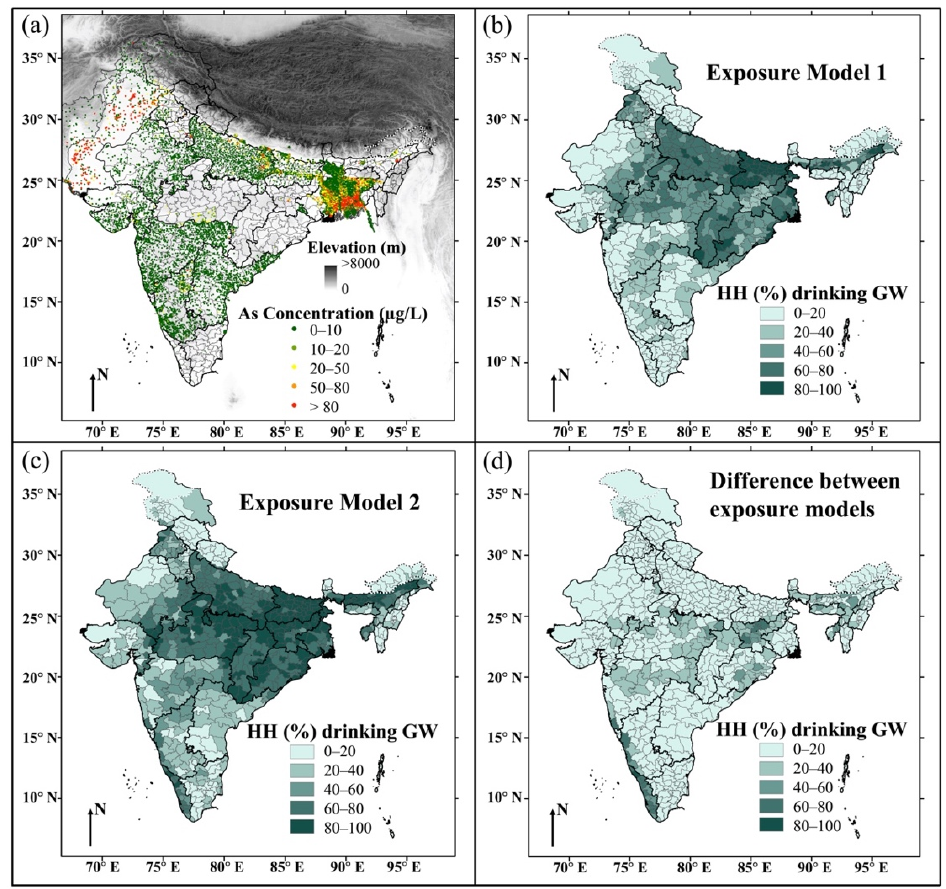
Figure 1. District-wise map of spatial distribution of India groundwater arsenic and exposure data utilized in this study. ( a ) District averaged arsenic concentrations and topographic elevation. ( b ) Exposure model 1: district-wise percentage of households (HH) drinking groundwater via hand pumps and tube wells/boreholes. ( c ) Exposure model 2: district-wise percentage of households (HH) drinking groundwater via covered/uncovered wells, hand pumps, and tube wells/boreholes. ( d ) Difference (expressed as percentage of households) between exposure models 1 and 2.